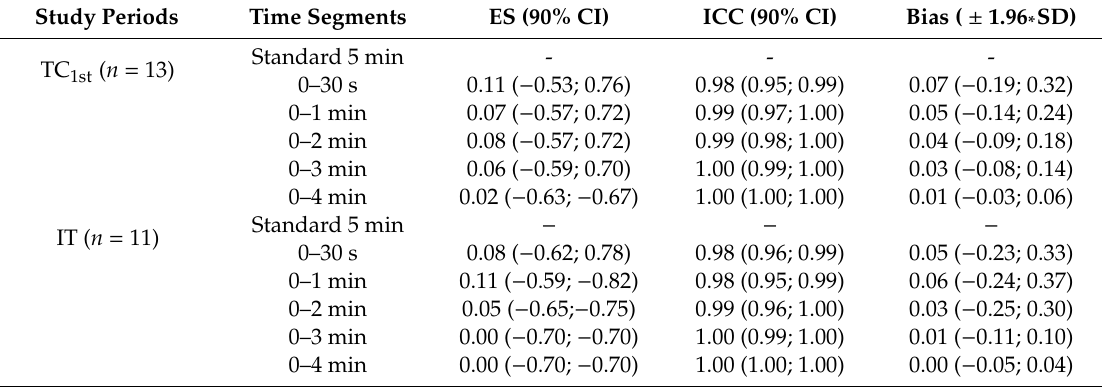
Table 2. Mean of natural logarithm of the root mean square di ff erences between adjacent normal